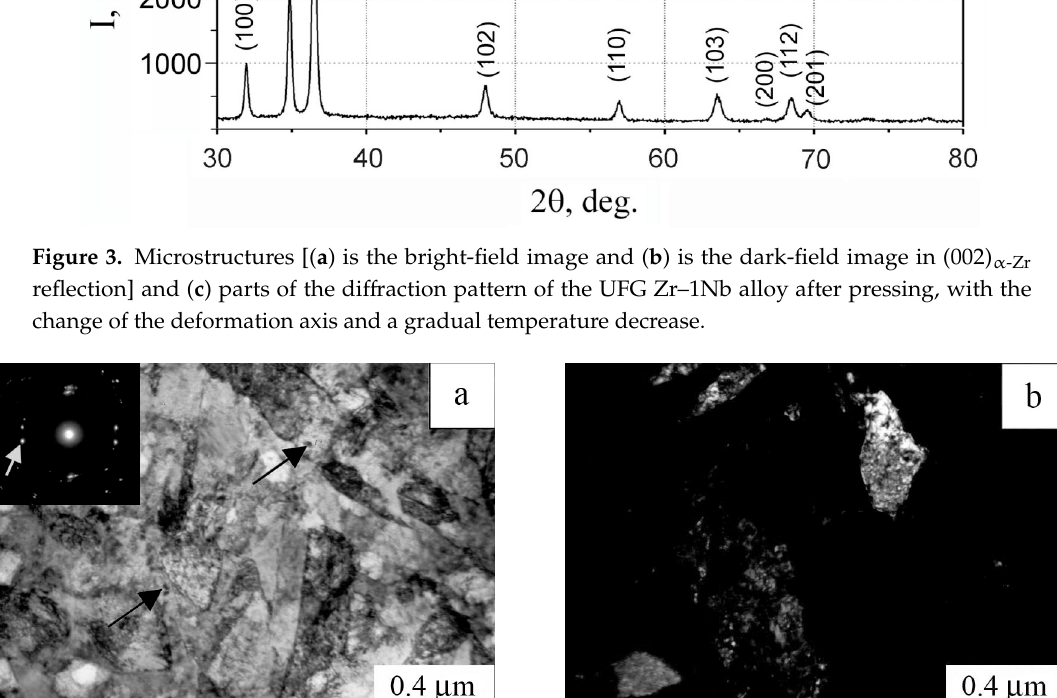
Figure 4. Microstructures of the UFG Zr–1Nb–0.33H alloy after pressing: ( a ) is the bright-field image and ( b ) is the dark-field image in (002) α -Zr reflection.